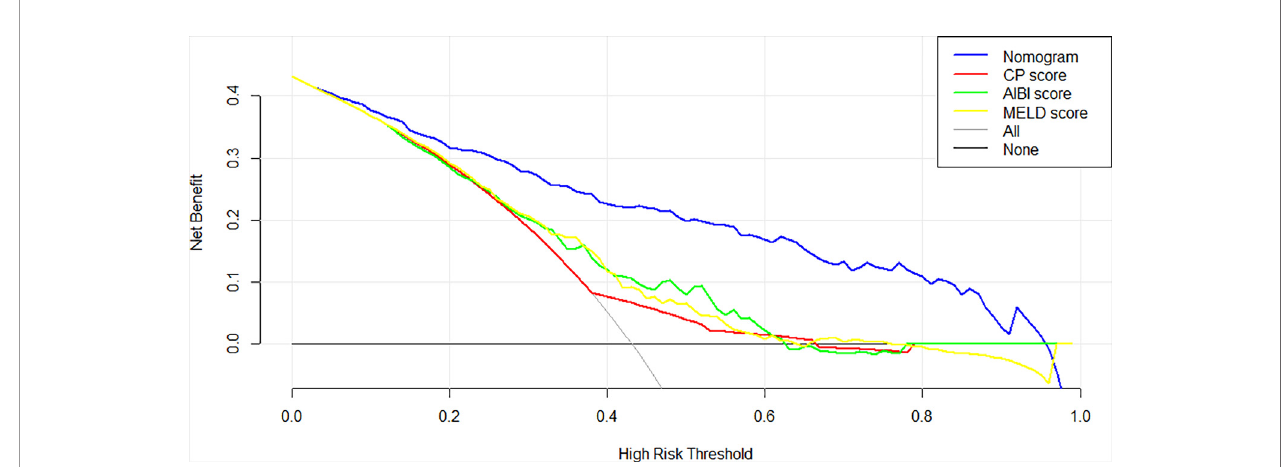
FIGURE 6 | Decision curve analysis of nomogram and the conventional models in the training cohort.